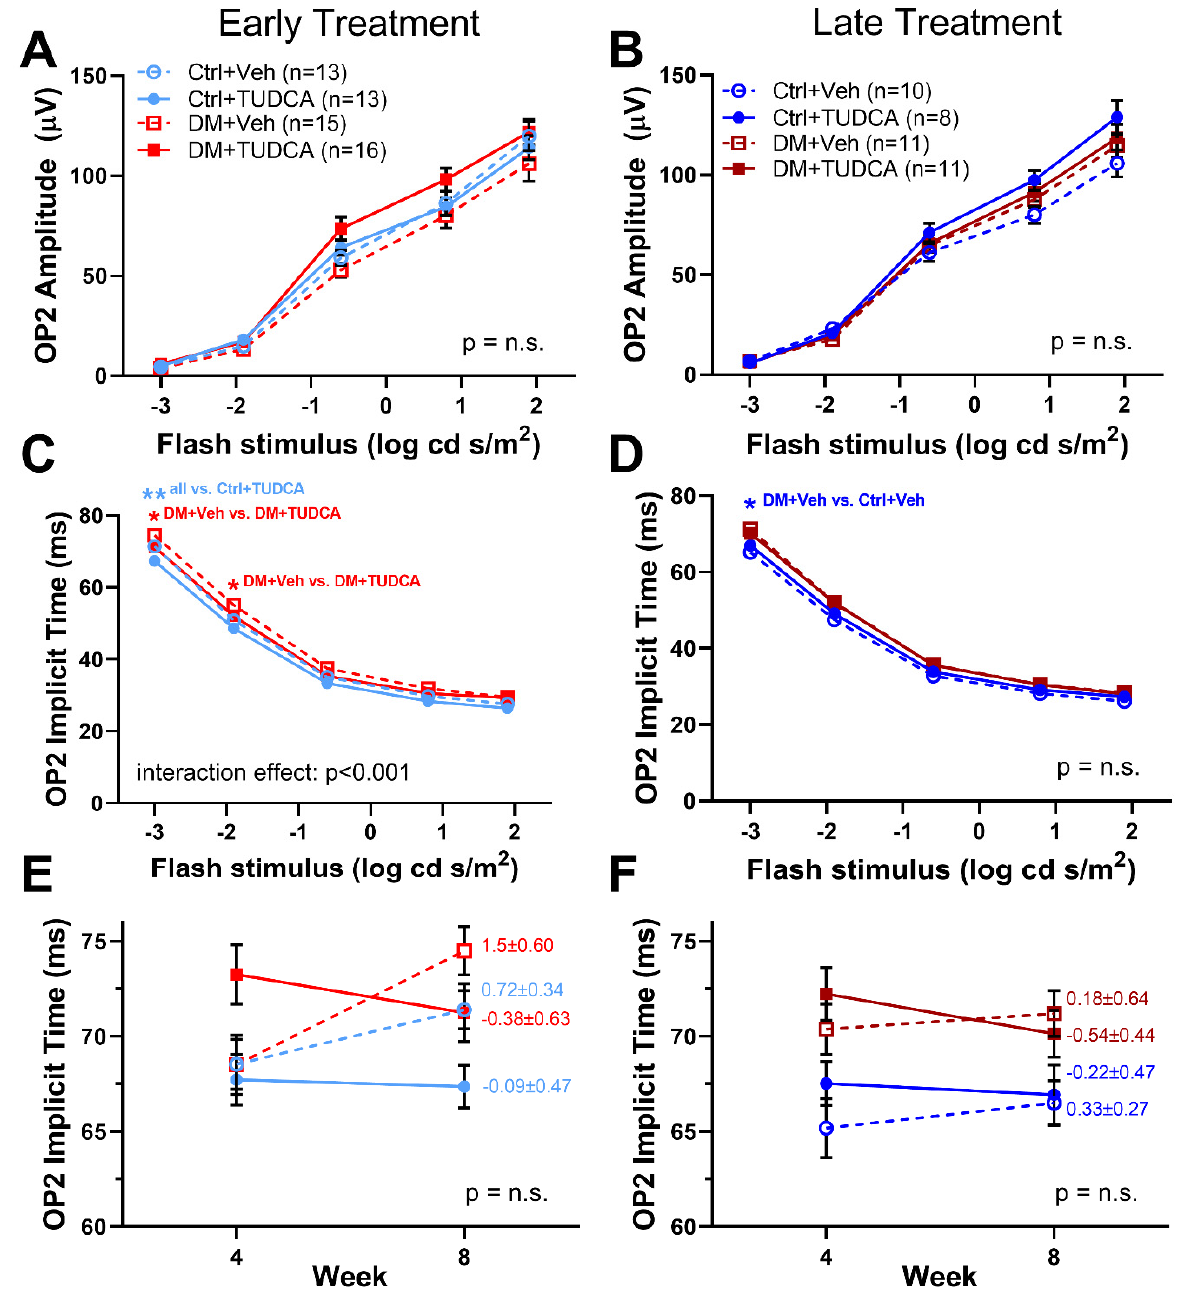
Figure 5. Early TUDCA treatment preserved ERG OPs in diabetic mice. ( A ) With early treatment, OP2 amplitudes at 8 weeks post-STZ were similar between groups. ( B ) With late treatment, OP2 amplitudes at 8 weeks post-STZ were similar between all treatment groups. ( C ) With early treatment, OP2 implicit times at 8 weeks were significantly delayed in the DM+Veh group at the two dimmest flash stimuli compared to DM+TUDCA (two-way repeated measures ANOVA F 12,212 = 3.541, interaction effect p < 0.001). ( D ) With late treatment, OP2 implicit times were similar for all groups. ( E ) With early treatment, OP2 implicit times were plotted for 4 and 8 weeks post-STZ and the slope of the change calculated. While the DM+Veh group had a positive slope, the DM+TUDCA group was negative. ( F ) In the late treatment group, the slope of the OP2 implicit times were reduced, but still showed a similar trend, with the slope of the DM+Veh group having positive values and the DM+TUDCA group having negative values. Holm–Sidak post hoc comparisons indicated by asterisks: * p <0.05, ** p <0.01; n.s. = not significant.